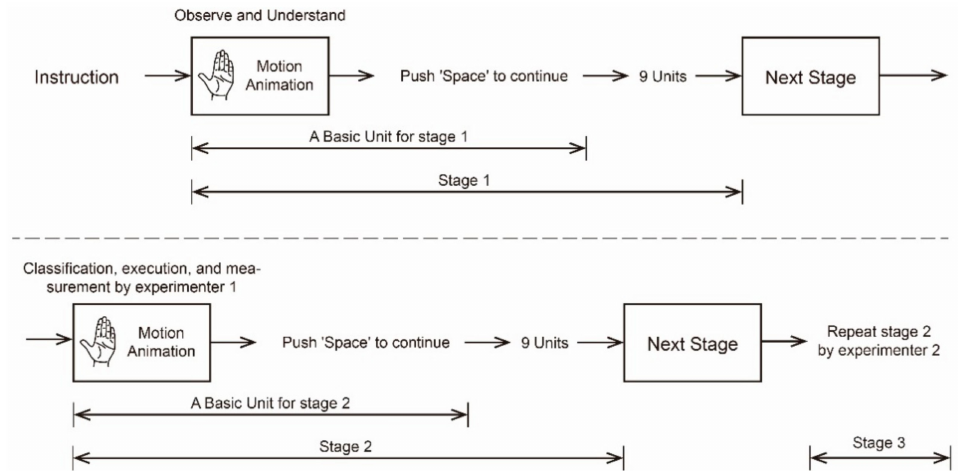
Figure 10. Experimental flowchart of motion primitive unit semantic state expression measurement. The experiment consists of three stages, and each stage has ten basic units, corresponding to ten motion primitive units. The first stage was executed in order to let the subjects understand the motion form of the motion primitive units; the second and third stages used the same process but different experimenters to record and measure the division and execution of the semantic state of each motion primitive